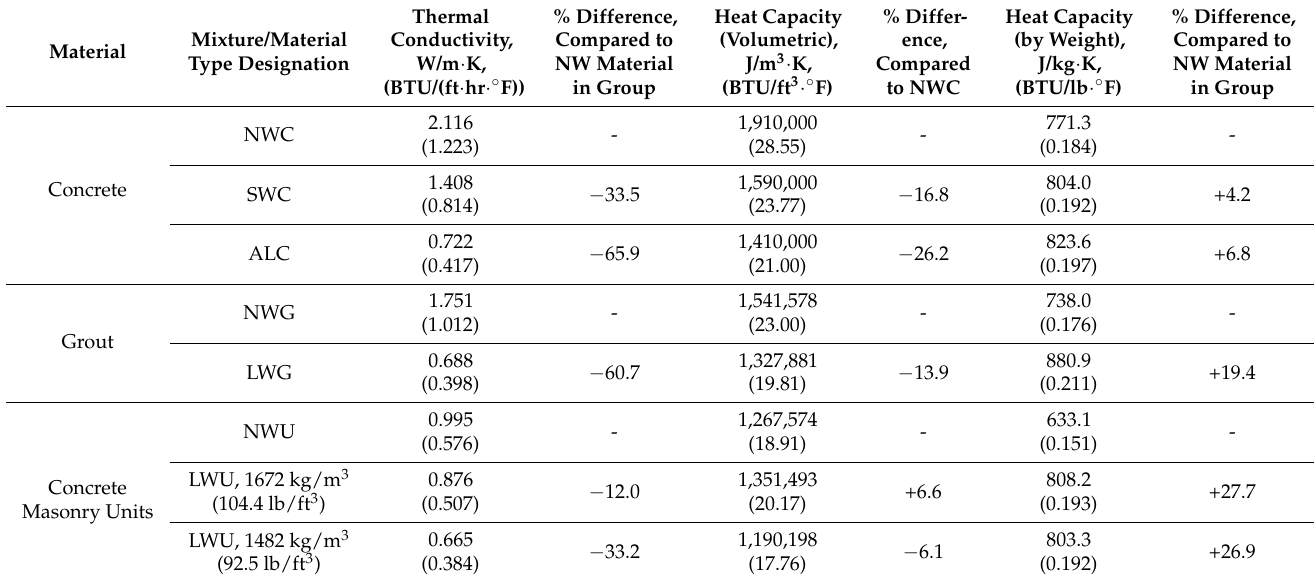
Table 7. Summary of thermal test results.